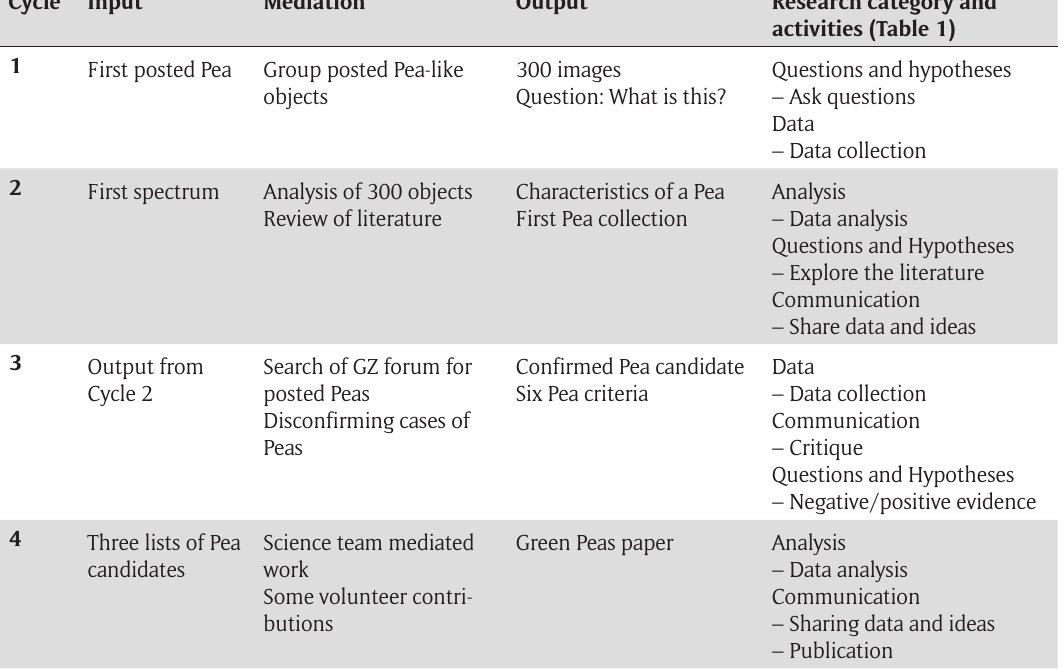
Table 3: IMOI cycles with science research